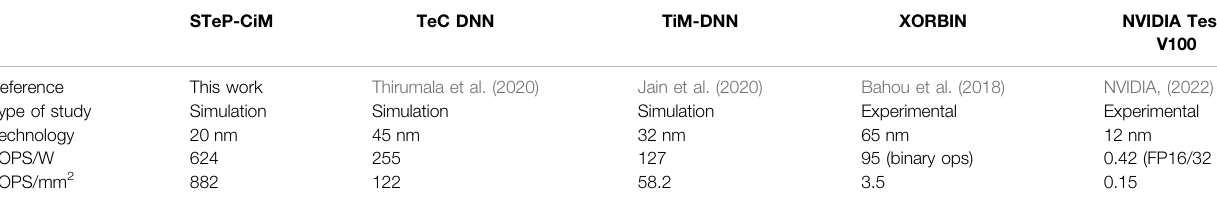
TABLE 4 | System-level comparison with state-of-the-art